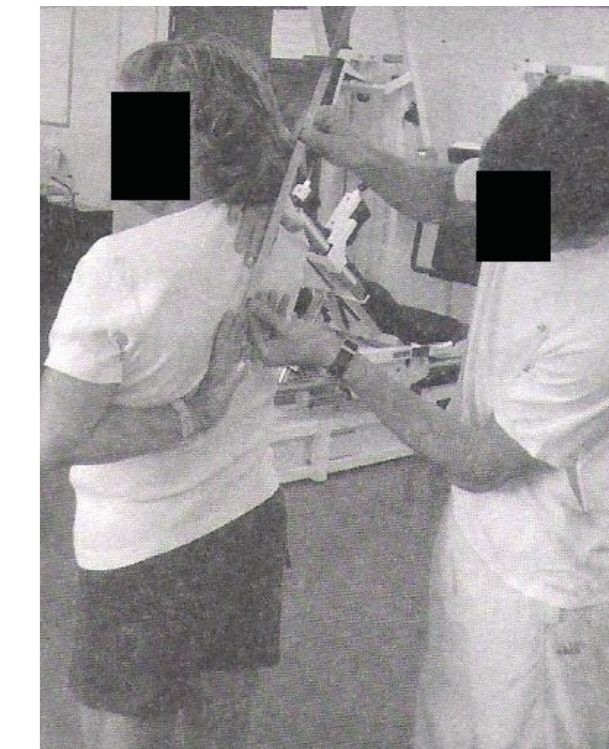
Figure 1 - Sit and reach test Source: Rikli and Jones (15).